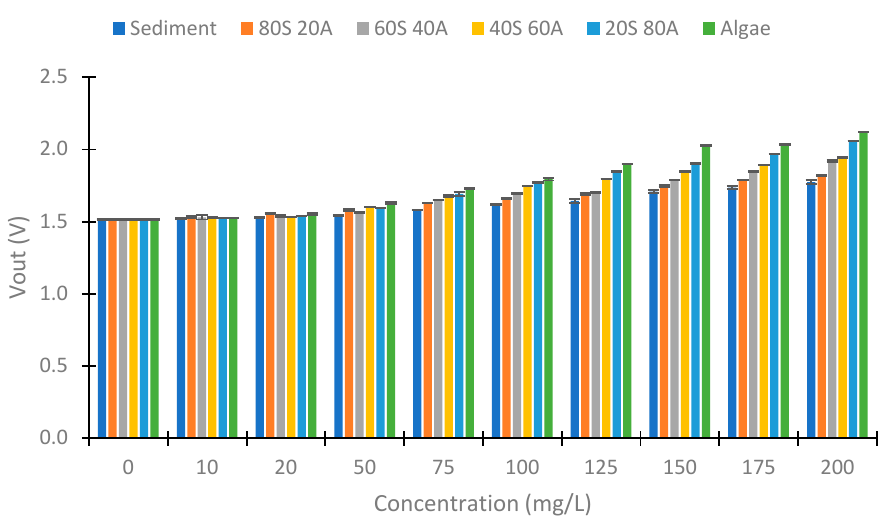
Figure 14. Vout with the use of blue light at voltage divider LDR at 180 ◦ .